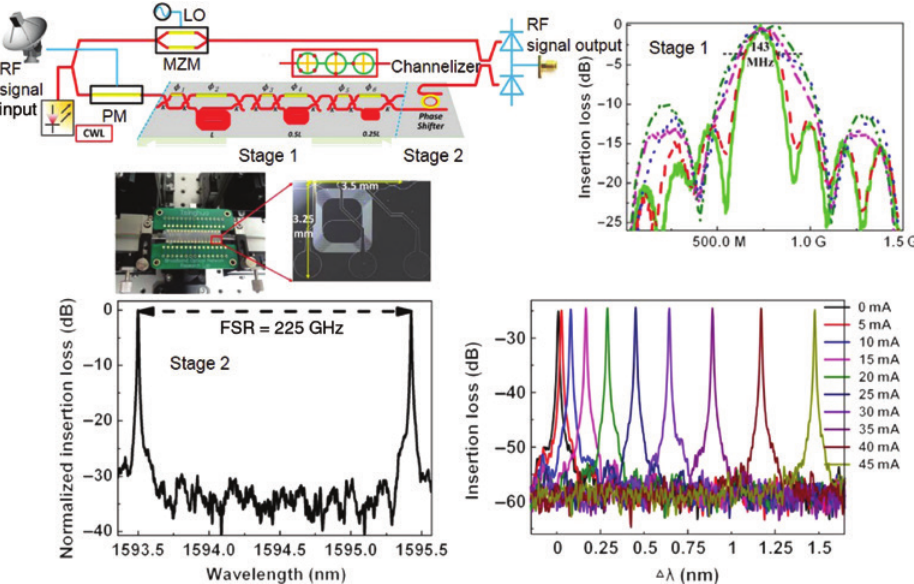
Figure 11: Design and realization of a highly selective signal channelizer featuring a frequency resolution of 143 MHz and an operation range of 112.5 GHz [75] (Copyright in 2015,